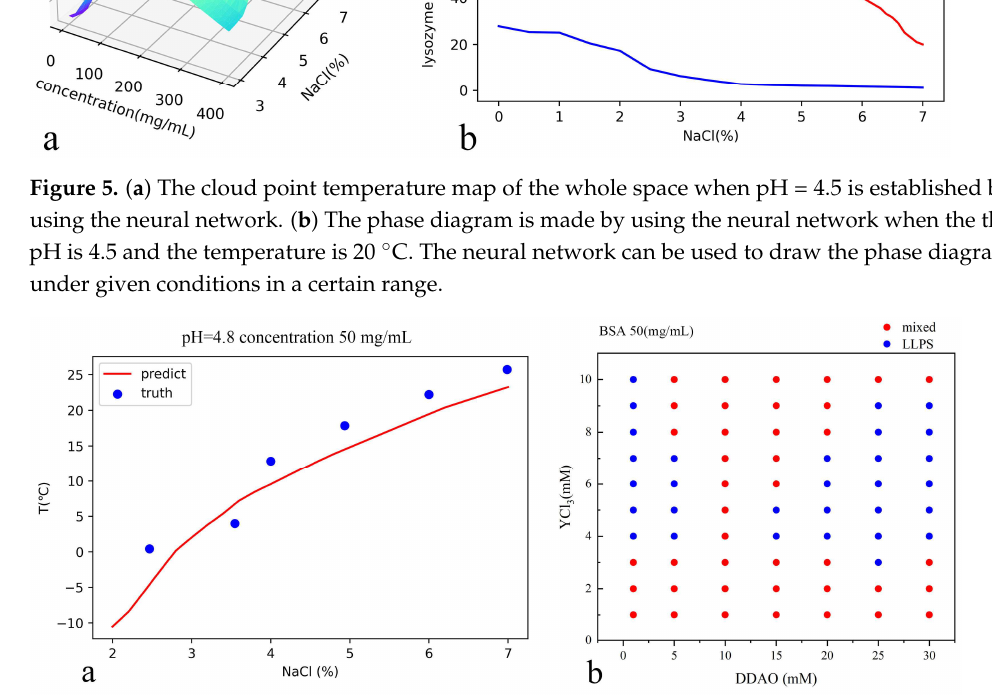
Figure 6. ( a ) pH 4.8 and lysozyme concentration 50 mg/mL, the cloud point temperature is compared with the experimental data from Ref. [28]. The MAE between the predicted and experimental values is 3.2. ( b ) BSA 50 mg/mL, the predicted results at different concentrations.